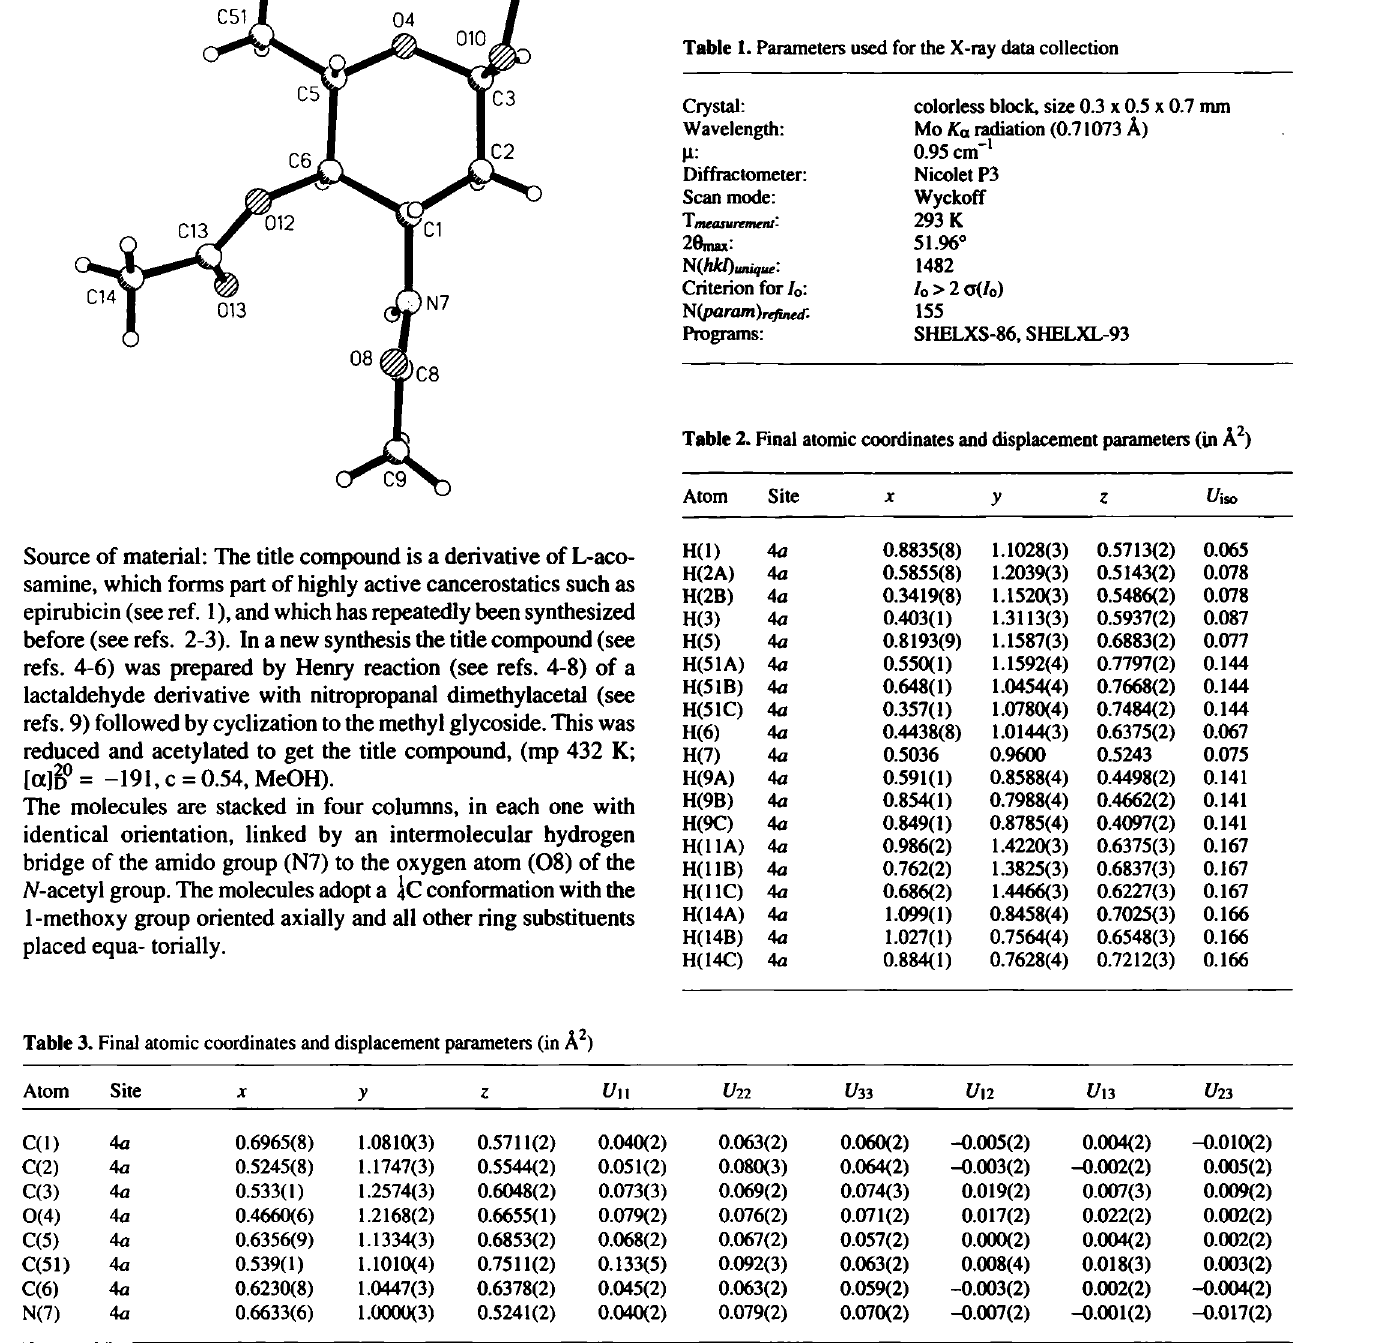
Table 1. Parameters used for the X-ray data collection Ciystal: